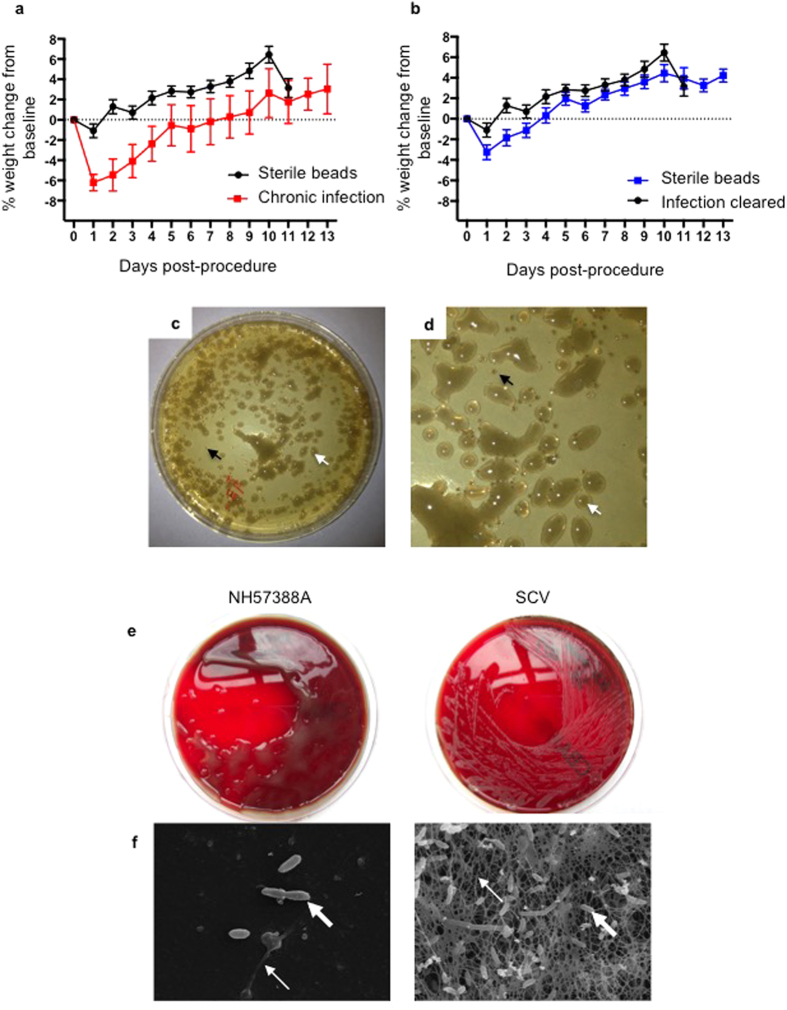
Weight loss and bacterial adaptation in mice infected with NH57388A-laden agar beads.(a,b) Body weight measured daily in C57BL/6 mice treated with sterile or Pseudomonas aeruginosa-laden agar beads. Animals who were infected with NH57388A-laden beads and, at 2-weeks post-inoculation, remain infected are denoted as ‘Chronic infection’ (a), where as those who do not have pulmonary infection are denoted ‘Infection cleared’ (b). Percentage weight change from baseline for pooled experiments with animals treated with NH57388A-laden beads (N = 35) compared with controls treated with sterile beads (N = 30 mice). Each point represents mean of group and SEM. (a) Difference between groups significant at p < 0.0001 via repeated measures ANOVA. (b) Difference between groups significant at p = 0.0204 via repeated measures ANOVA. (c,d) Mucoid (white arrow) and small colony variants (black arrow) identified in lung homogenate of NH57388A-laden bead treated animal 2-weeks following inoculation. (e) Subcultures of mucoid NH75388A and small colony variant (SCV) phenotypes isolated from the lungs of animals treated with NH57388A-laden beads (grown on blood agar). (f) Transmission electron microscopy of biofilms of mucoid NH57388A and its small colony-variant. Mucoid NH57388A demonstrated low bacterial density with limited extracellular matrix. The related SCV produced a biofilm with a high density of highly adherent bacteria embedded in a dense network of extracellular material. Bacteria indicated by think white arrow and extracellular matrix by thin white arrow.